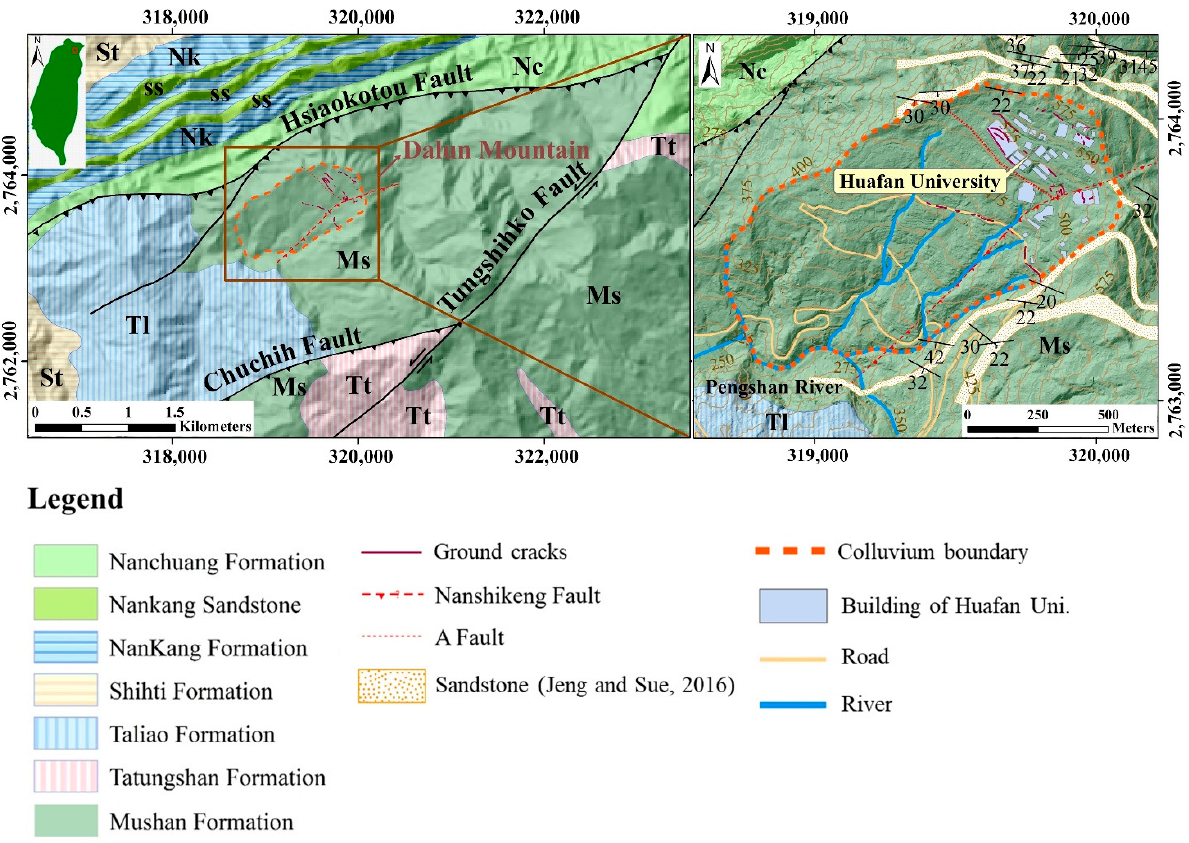
Figure 1. Location and geological map of the Mt. Dalun area. The attitudes of bedding plane are derived from the study of Jeng and Sue [28]. The orange dotted line indicates the area where the main colluvium is distributed; potential sliding blocks are estimated to occur within this area.